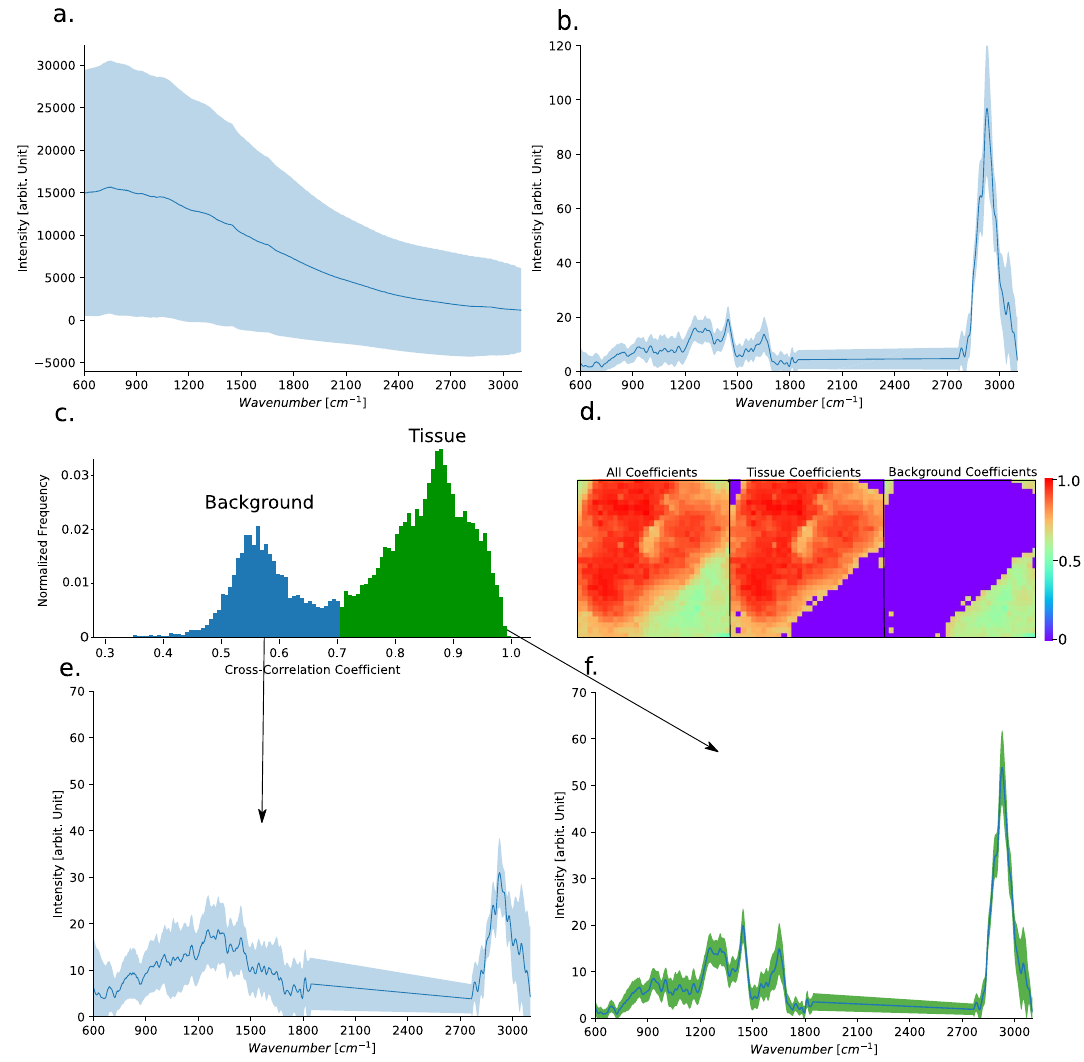
Figure 7. Raman spectra of biological tissue, specifically of bladder, contain significant autofluorescence contributions and require substantial data-pre-processing. The mean raw-spectrum and the standard deviation is displayed for all bladder biopsies, ( a ) The background-corrected and area-normalized mean-spectra with standard deviation are shown in ( b ) Normalized correlation coefficient-value occurrence plotted as a normalized histogram, revealing two separate distributions, i.e. background and tissue below and above a correlation-value of approx. 0.7 ( c ) An example for the separation of background signal and tissue signal, a map of the correlation values is presented for an entire biopsy and the separation, based on the presented threshold value of 0.7, ( d ) Additionally, the mean and standard deviation spectra are plotted, i.e. for correlation- values < 0.7 (background), ( e ) and correlation values > 0.7 (tissue), ( f